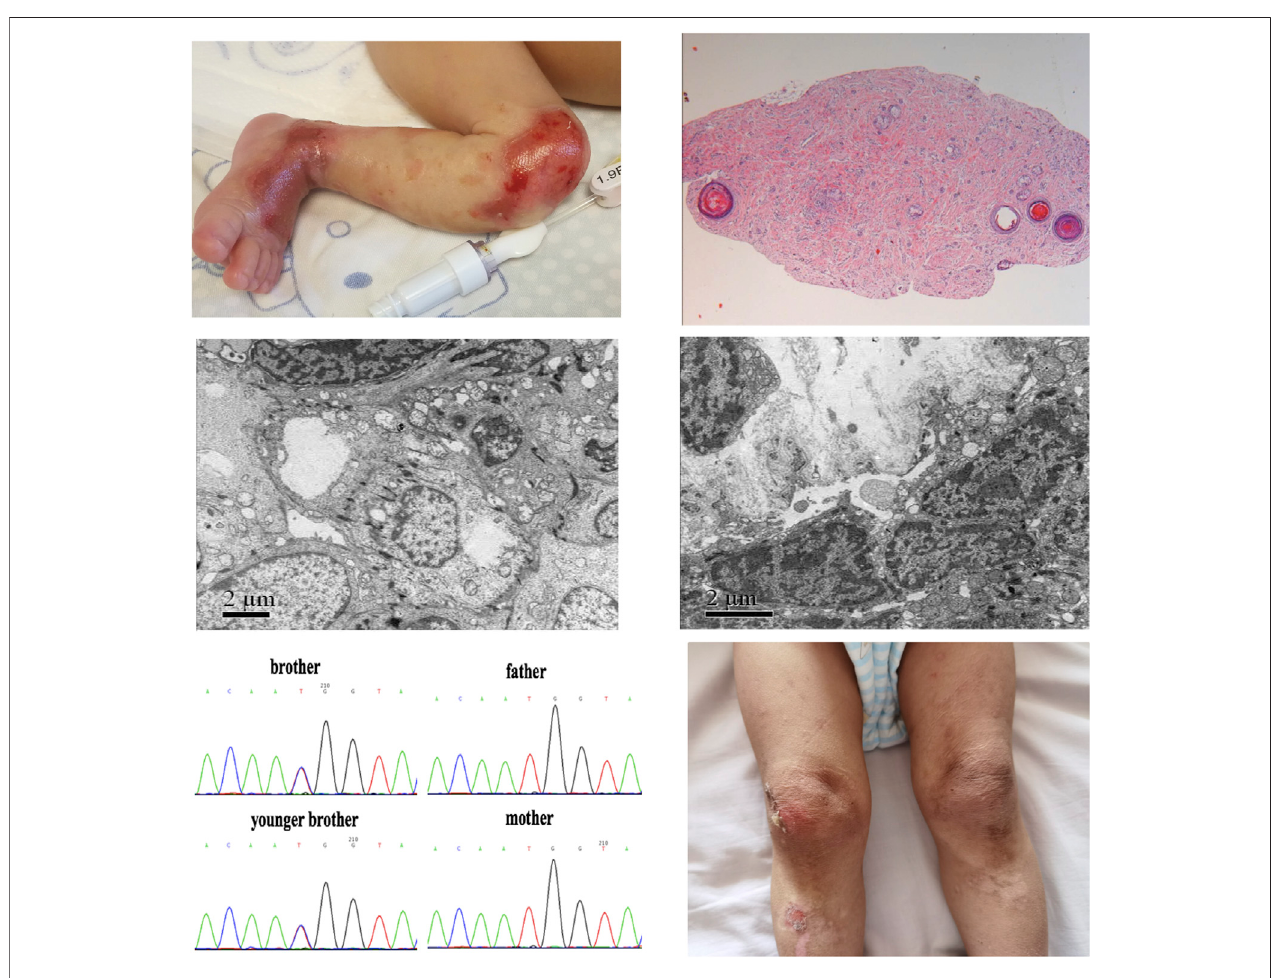
FIGURE1 | Skin image, pathology,and de novo pathogenic variants of KLHL24 in the twin brothers. (A) Picture ofthe older brother ’ s left leg at birth demonstrated congenital skin defects. (B) Histopathological examination of HE-stained skin in the older brother (C) Skin performance under EM in the older brother (D) Skin performance under EM in the younger brother (E) De novo pathogenic variants of c.2T > C (p.M1T) in KLHL24 of this ancestry (F) Picture of younger brother ’ s legs at the age of 2 years demonstrated skin damage, pigmentation and scar.